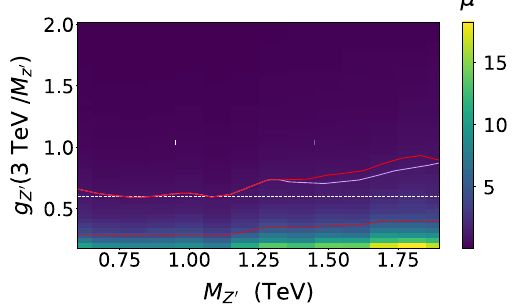
/ M 2 ) relative Z Z (cid:2)